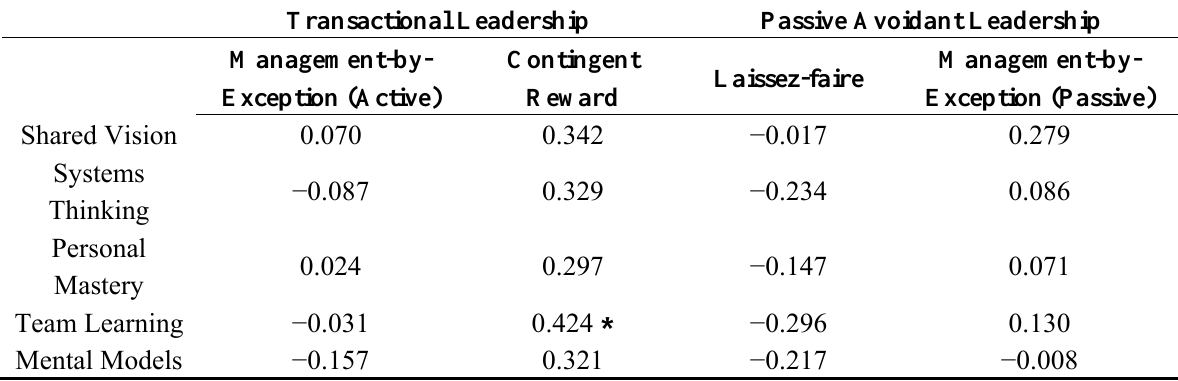
Table 5. Correlations between learning organization characteristics and transactional and passive-avoidant leadership